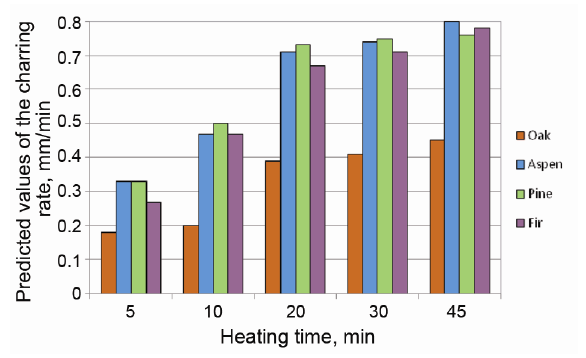
Fig. 12. Average values of predicted charring rates for wood